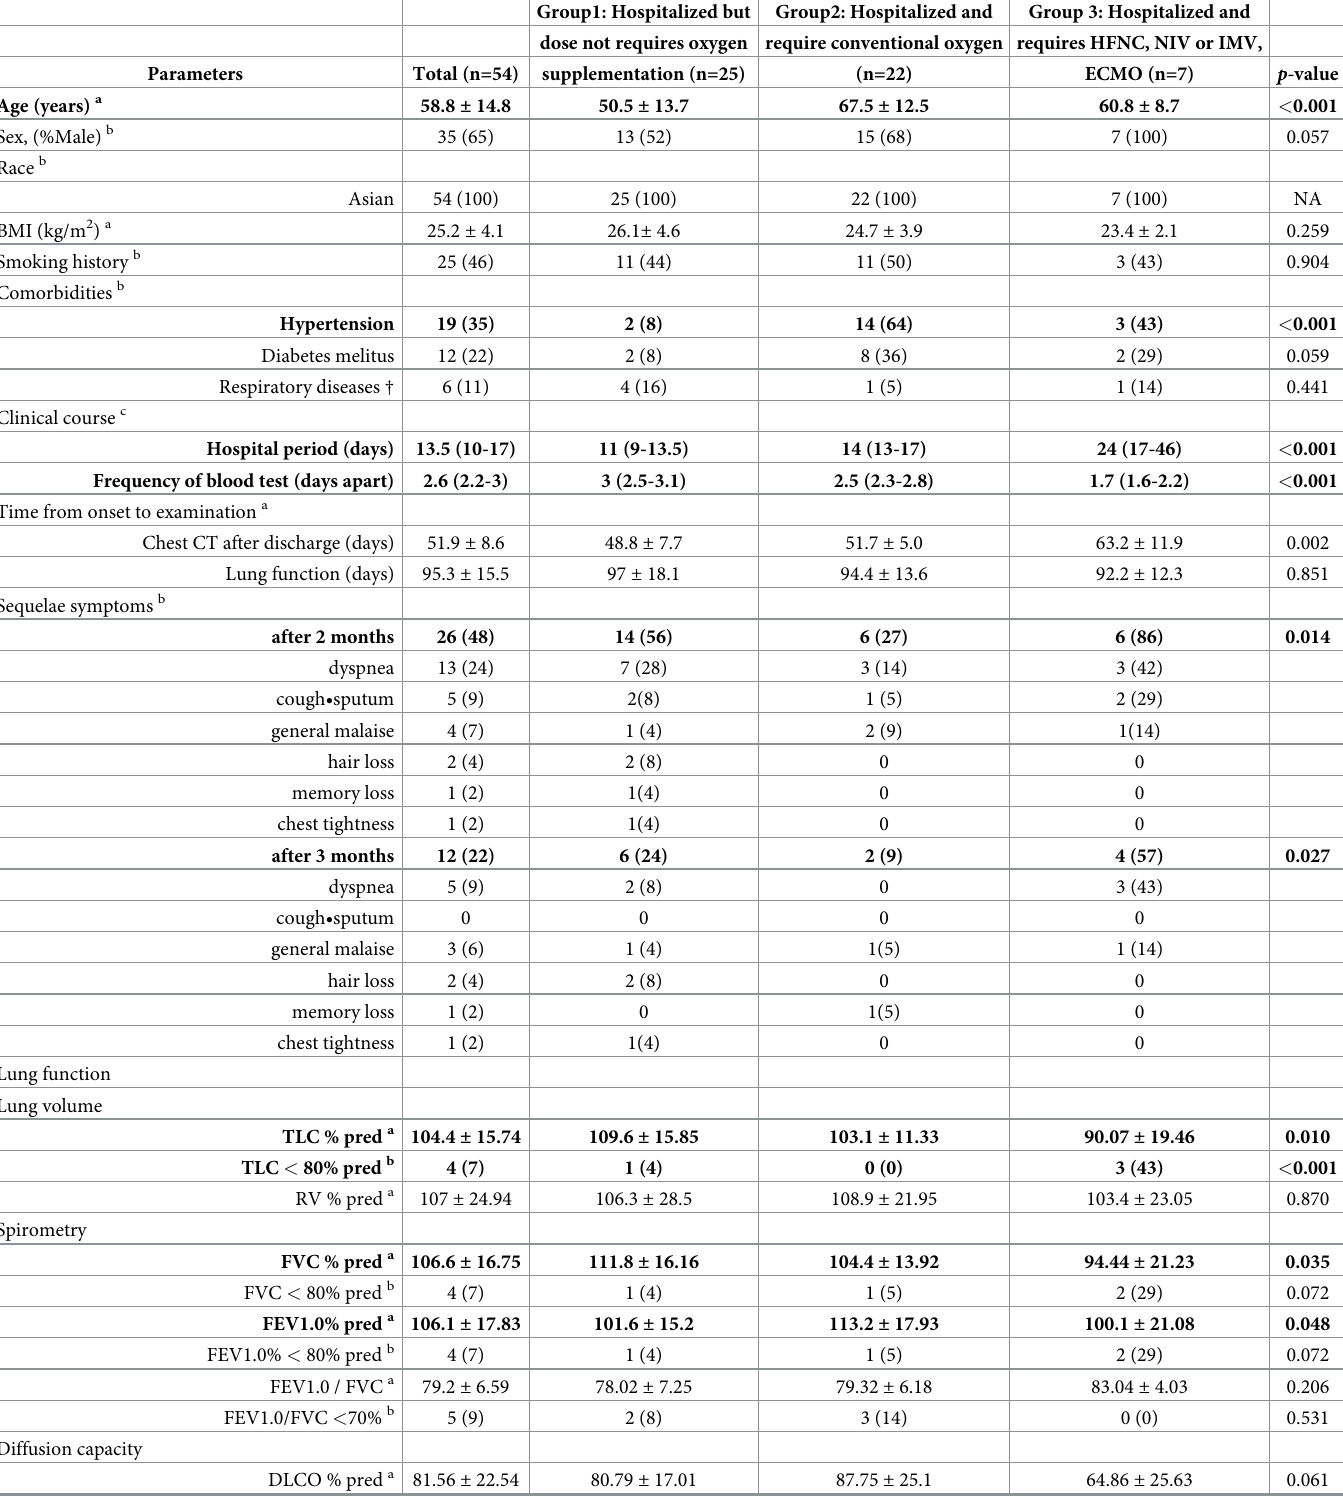
Table 1. Characteristics of patients and comparison by severity. Group1: Hospitalized but Group2: Hospitalized and Group 3: Hospitalized